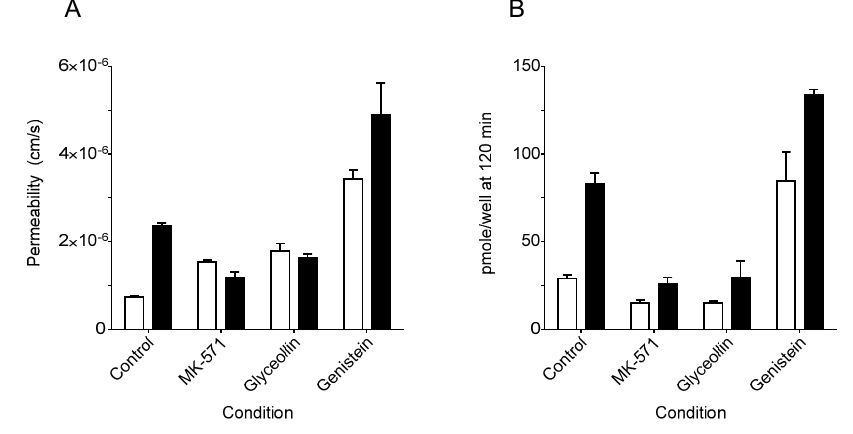
Figure 1. 5 (and 6)-carboxy-2 ′ ,7 ′ -dichloroflourescein (CDF) permeability in Caco-2 cells grown on Transwell ® filters. ( A ) CDF permeability; ( B ) amount of CDF in cells at 120 min. The condition refers to the absence of a putative inhibitor (control) vs. the presence of 100 µM of either MK-571, glyceollin or genistein. Open bars represent transport in the apical-to-basolateral (AB) direction and closed bars in the basolateral-to-apical (BA) direction. N = 16 experiments for controls and 3 experiments for each compound. An experiment consisted of three filters in each transport direction. For all three compounds, both permeability and cell amount measures were significantly different from the corresponding control/transport direction according to one-way ANOVA followed by Tukey’s t -test for multiple comparisons ( p < 0.05).